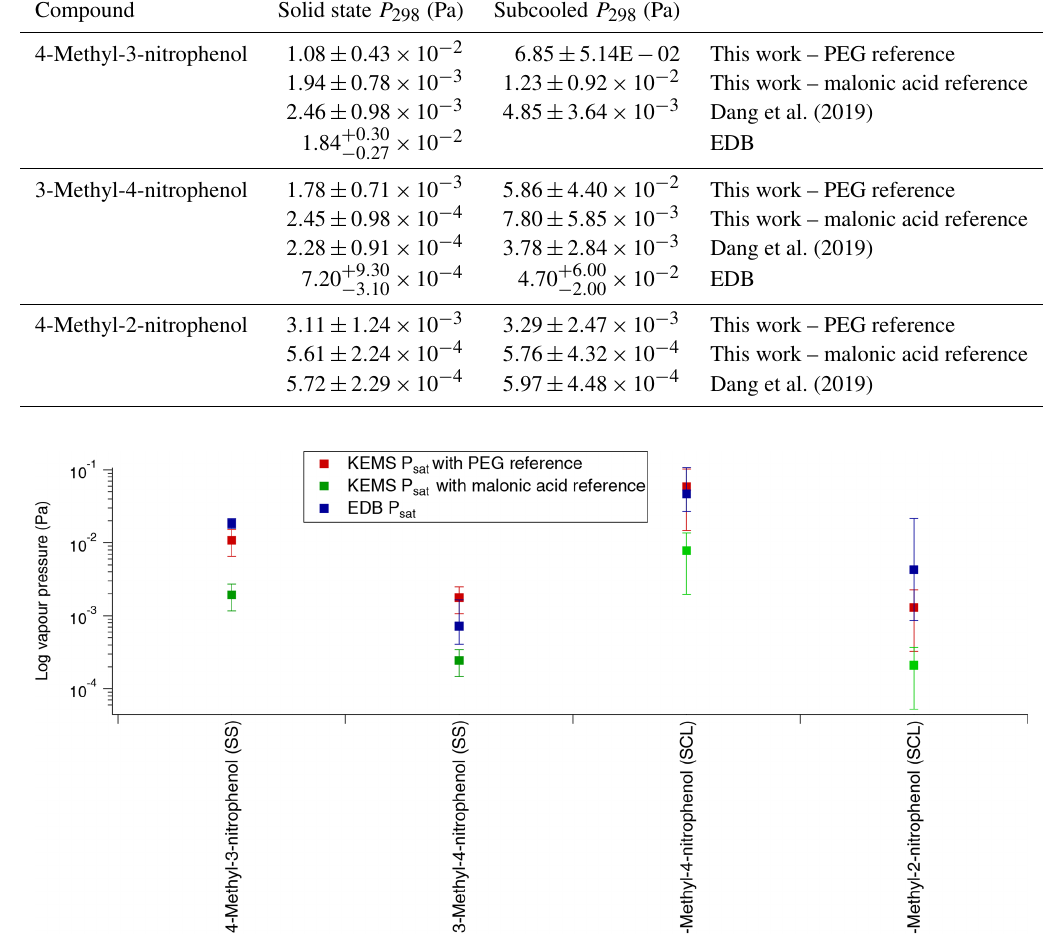
Table 9. Comparison between nitrophenols measured in this paper and by Dang et al. (2019). Compound